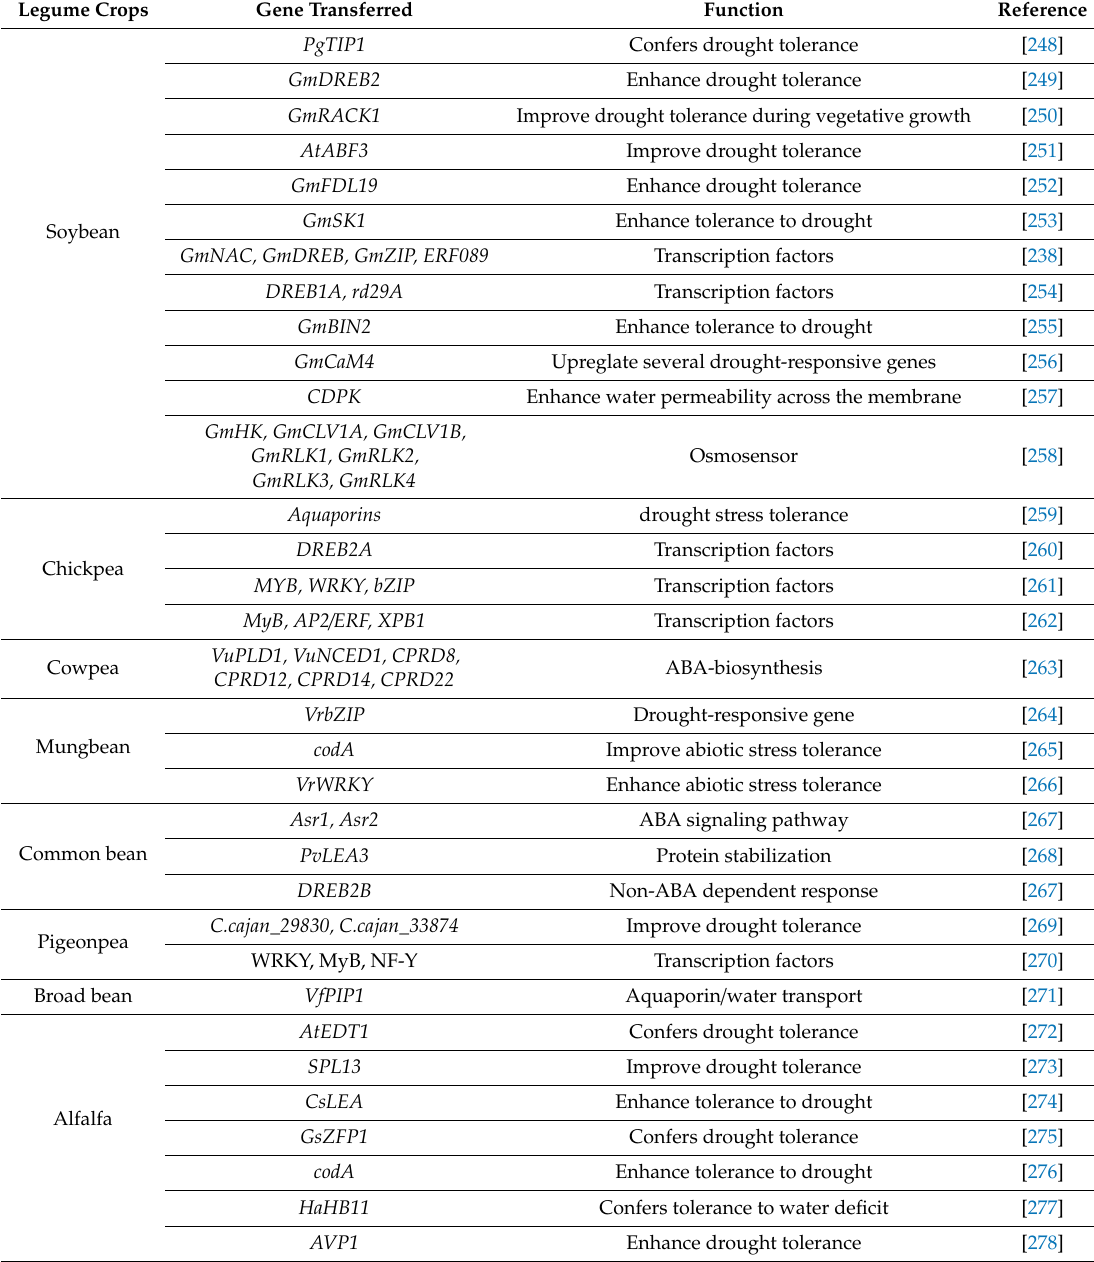
Table 4. Candidate genes explored for imparting drought resistance in